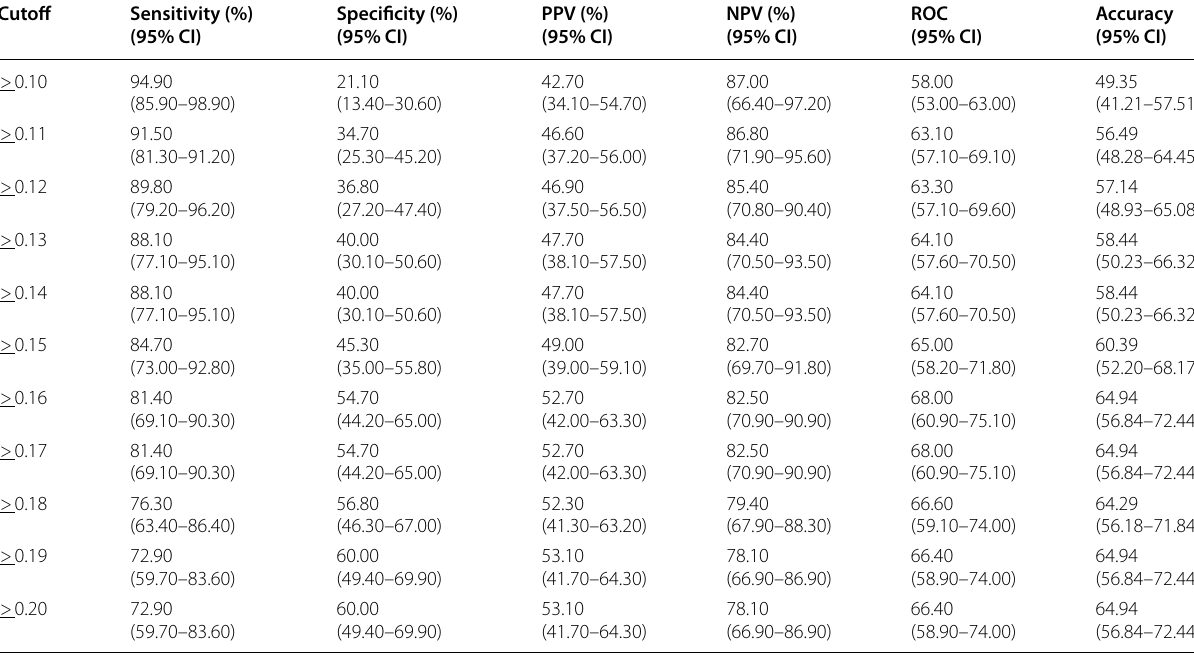
Table 3 Cutoff point for PSAD in the discrimination of prostate cancer of all patients Cutoff